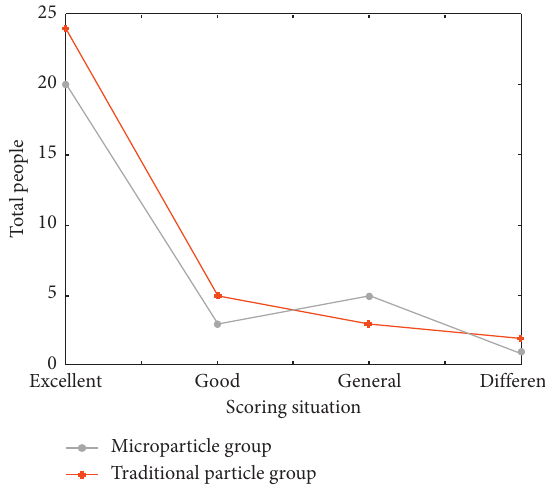
Figure 3: Comparison of bone healing between the two